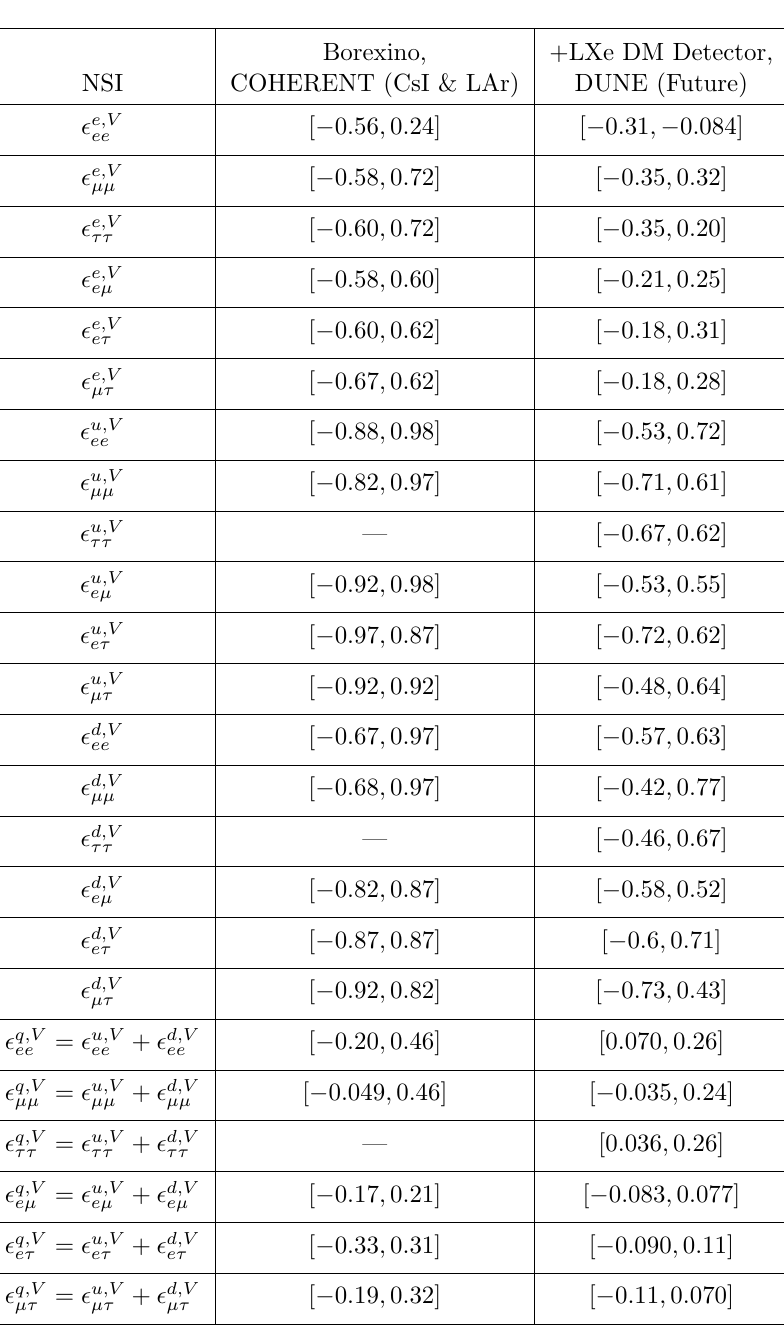
Table 3 . We show 95% credible intervals for the NSI parameters derived from existing data from Borexino and COHERENT (middle column), and projected constraints from the combined results of a LXe DM detector and DUNE (right column) whose priors were constructed from the posterior distributions on NSI from COHERENT and